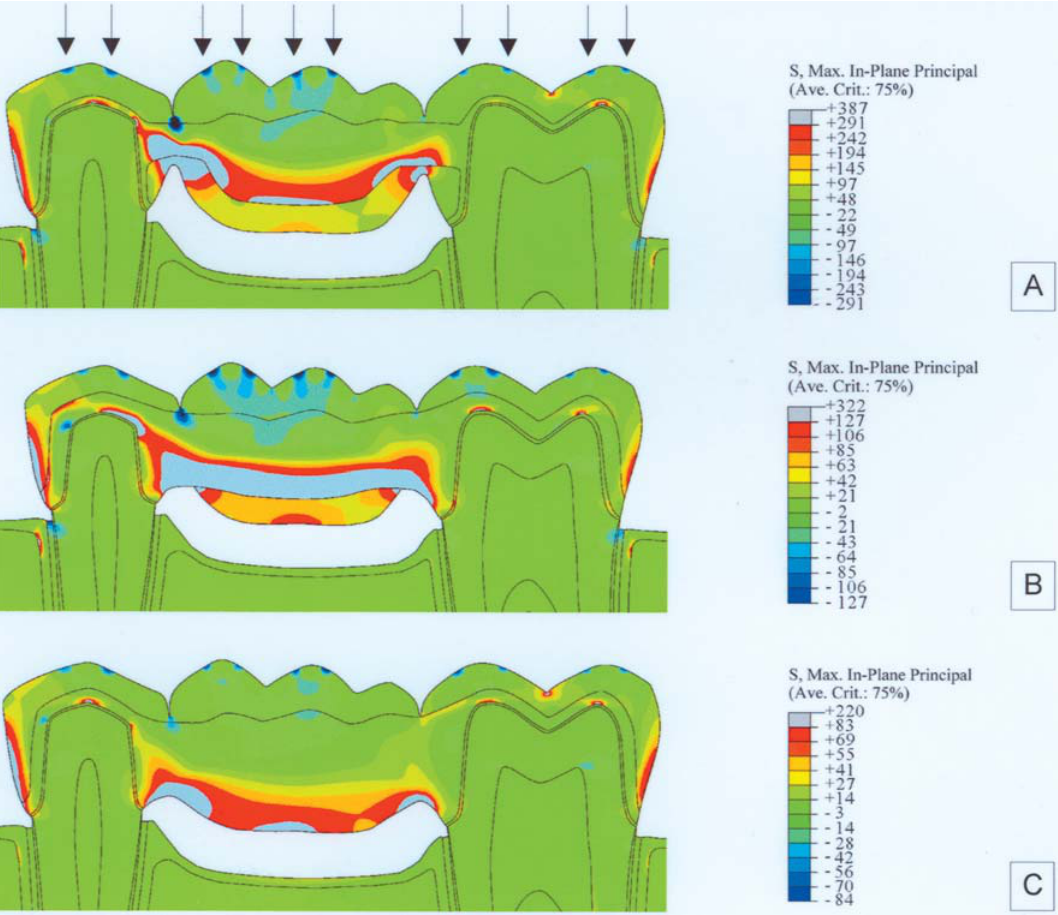
FIGURE 2- Stress distribution found when a physiological load was applied. Models: (A) Metal-ceramic FPD; (B) All-ceramic- OC FPD; (C) All-ceramic-O FPD